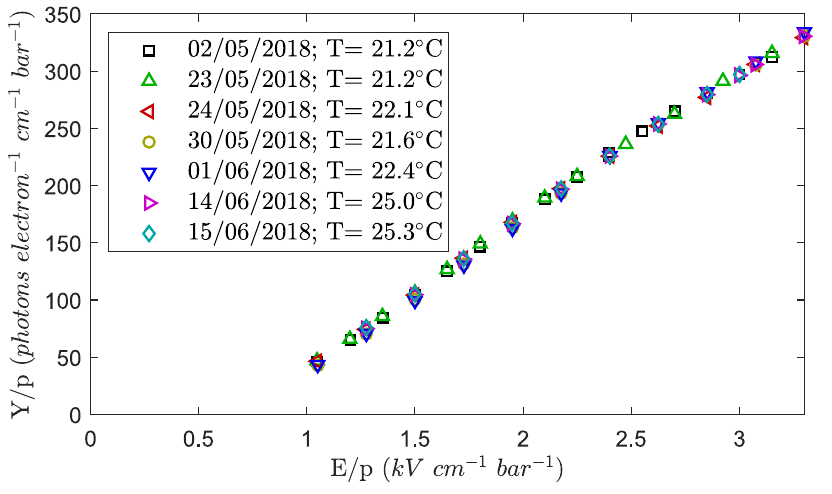
Figure 5 . EL yield, Y/p, for pure xenon, as a function of reduced electric (cid:12)eld E/p applied to the EL region, obtained in di(cid:11)erent runs with di(cid:11)erent LAAPD operation conditions.